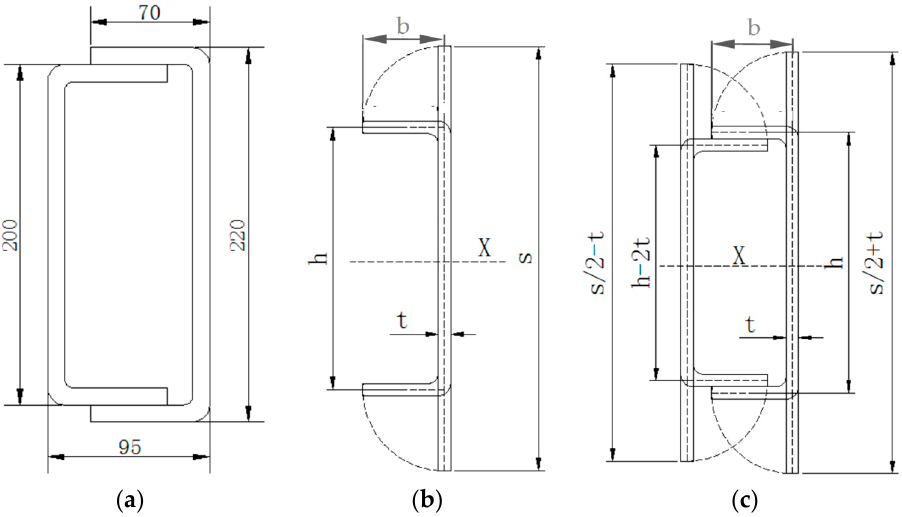
Figure 4. Longitudinal beam structure diagram. ( a ) Initial longitudinal beam section; ( b ) Slot cross-sectional drawing; ( c ) Stacked section diagram.